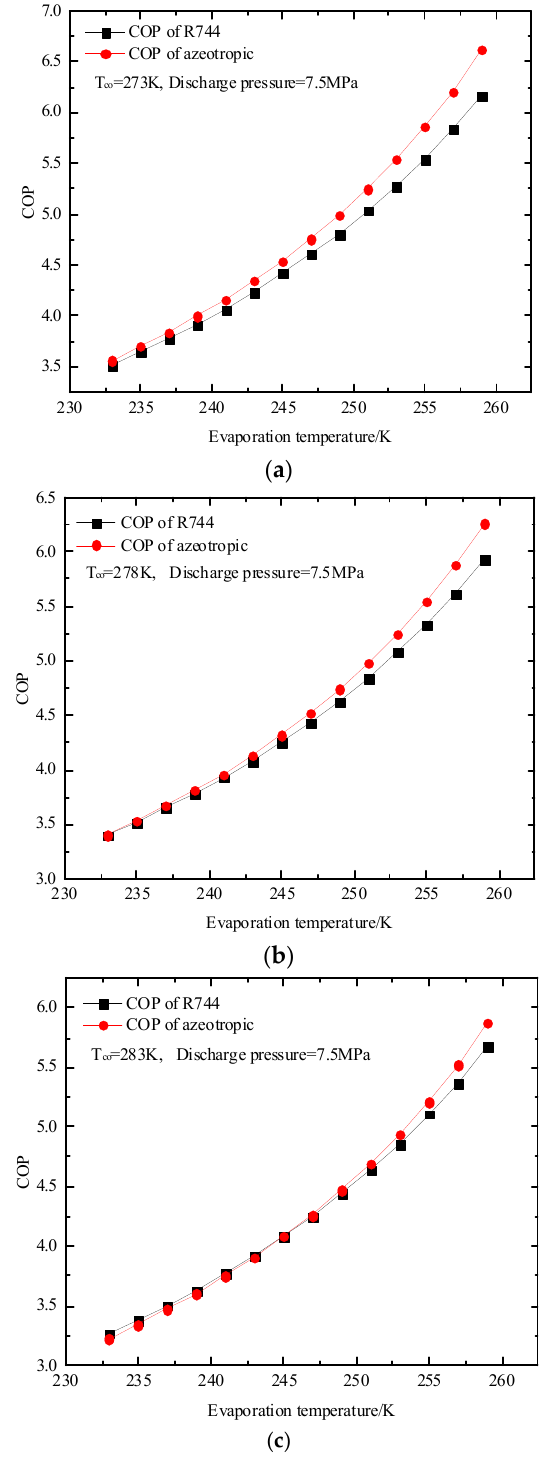
Figure 24. Comparison of COP of azeotropic refrigerant and R744 varies with evaporation temperature at different outlet temperatures of condenser: ( a ) T co = 273 K; ( b ) T co = 278 K; ( c ) T co = 283